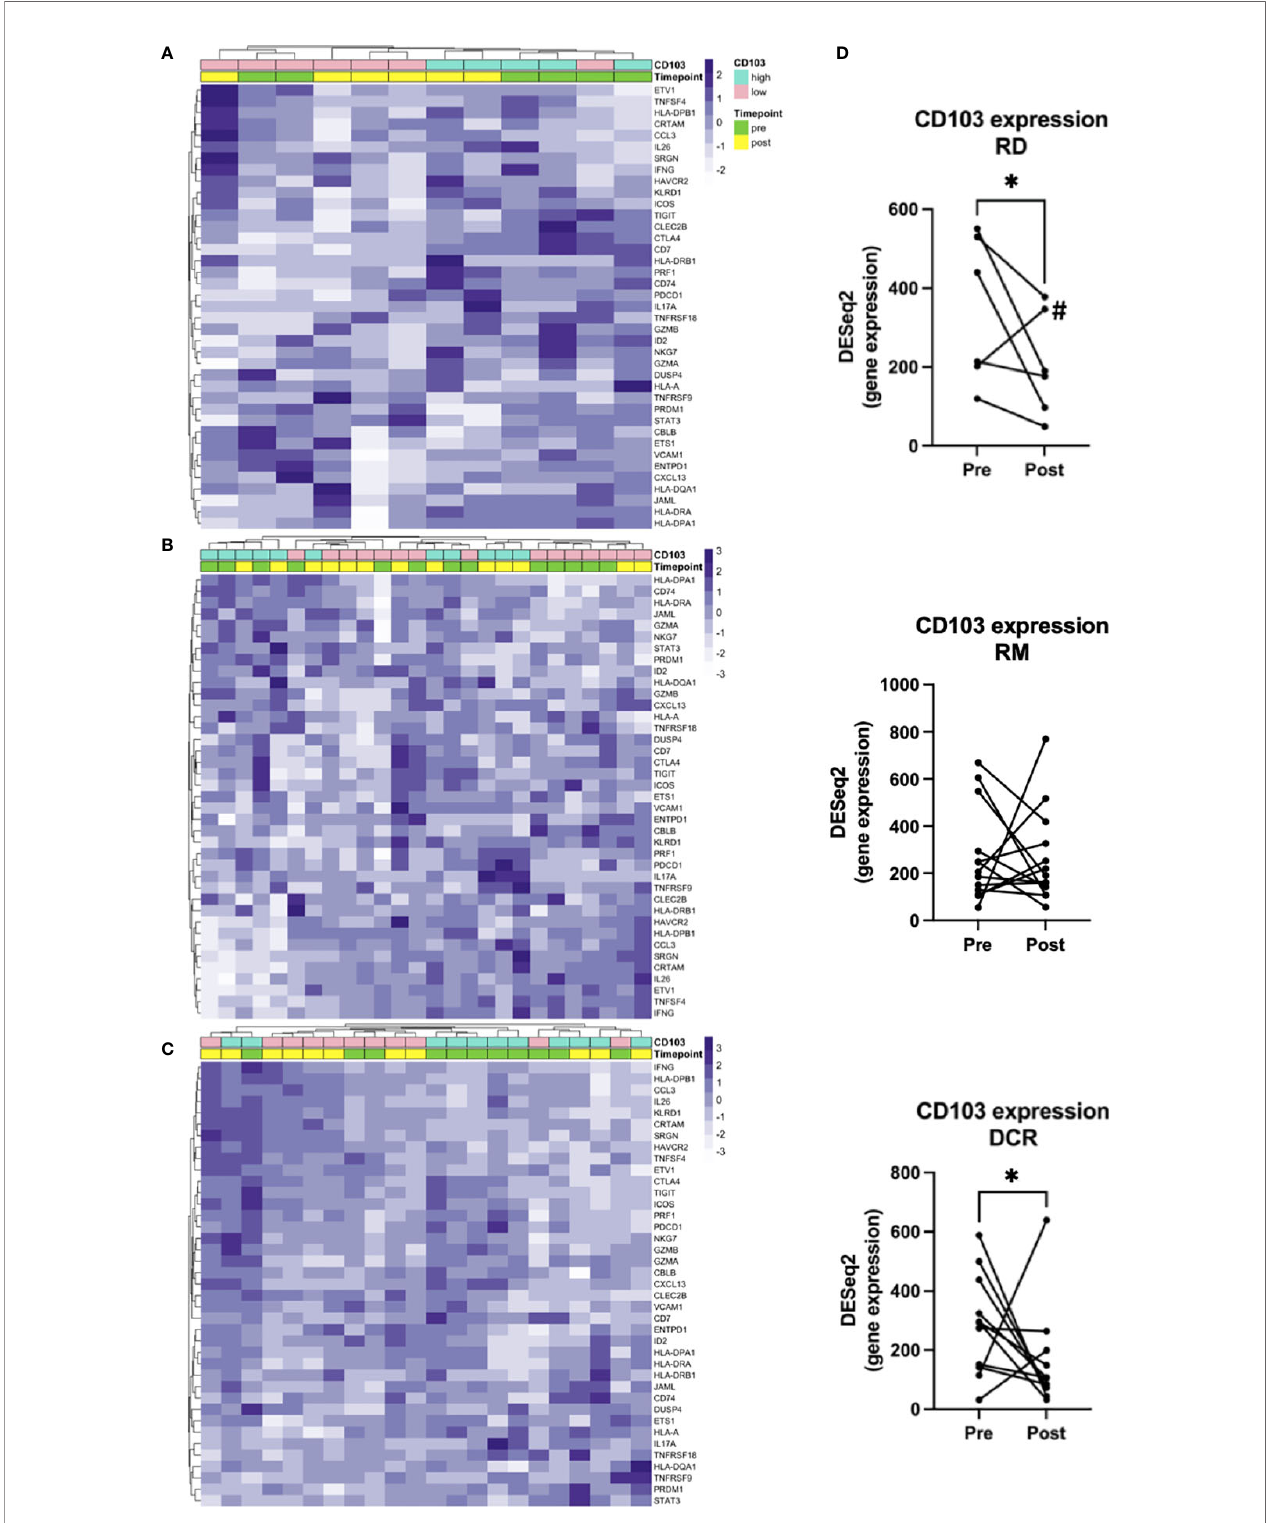
FIGURE 3 | Gene signatures de fi ning T RM . Unsupervised hierarchical clustering for (A) RD, (B) RM and (C) DCR indicates no clear changes before and after treatment. (D) shows corresponding changes of CD103 expression before and after CRT. # is indicating the Patient treated with RT and cetuximab. * indicates p <